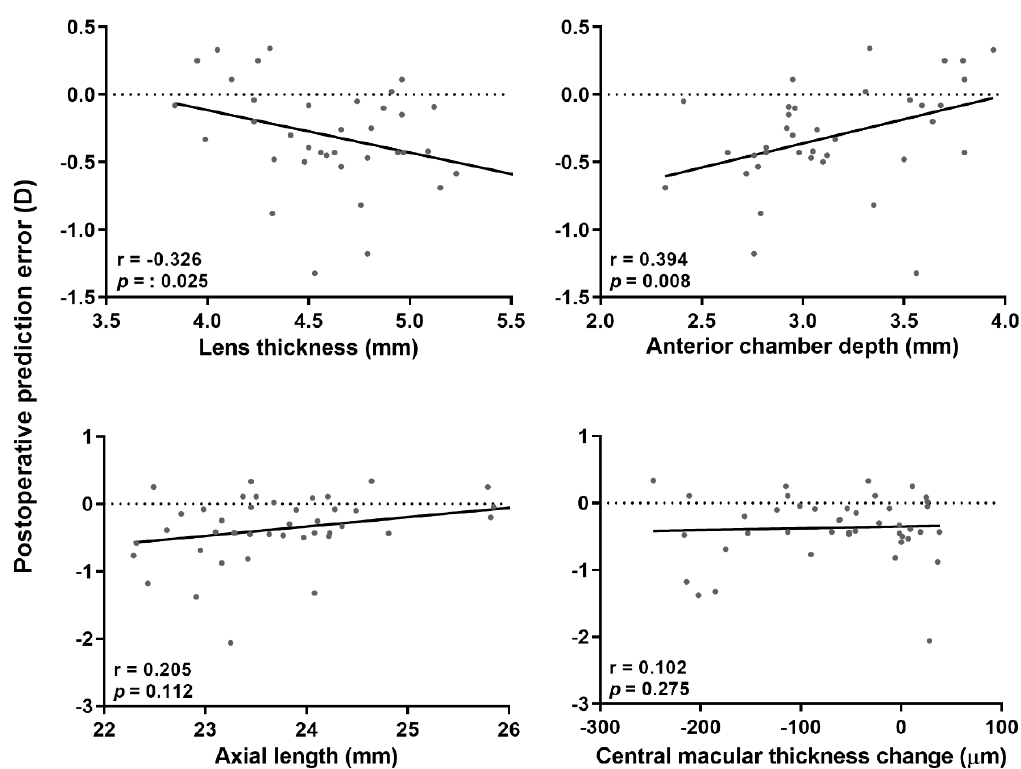
Figure 2. Correlation analysis of the relationships between preoperative factors and postoperative prediction errors (observed refraction – predicted refraction) for vitrectomized eyes. A relatively shallow anterior chamber and a thicker lens resulted in a significant myopic shift. The equations fitted to the regression lines for the regression analyses were as follows: y = − 0.314x + 1.144 ( p = 0.049, top left), y = 0.357x − 1.429 ( p = 0.016, top right), y = 0.139x − 3.663 ( p = 0.072, bottom left), and y = 0.000x − 0.349 ( p = 0.771, bottom right), respectively. Table 3. Comparison of changes in ocular biometry between the phacoemulsification group and the phacovitrectomy